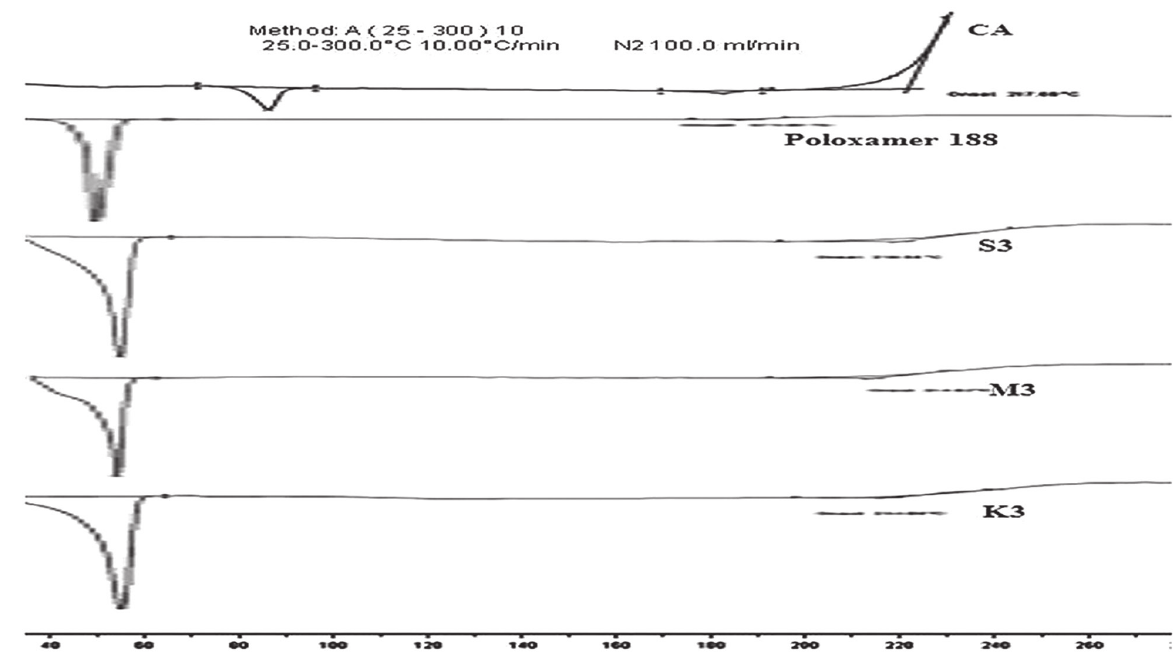
FIGURE 9 - Differential scanning calorimetric thermograms of cefuroxime axetil, poloxamer 188, and their